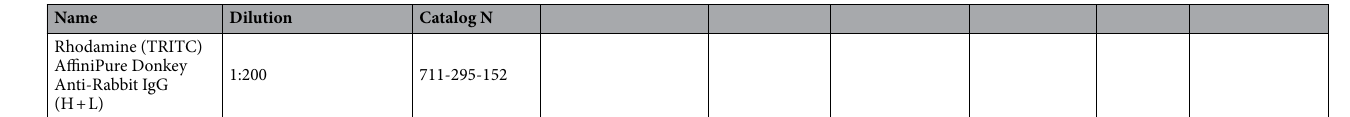
Table 1. Design and antibodies specifications.